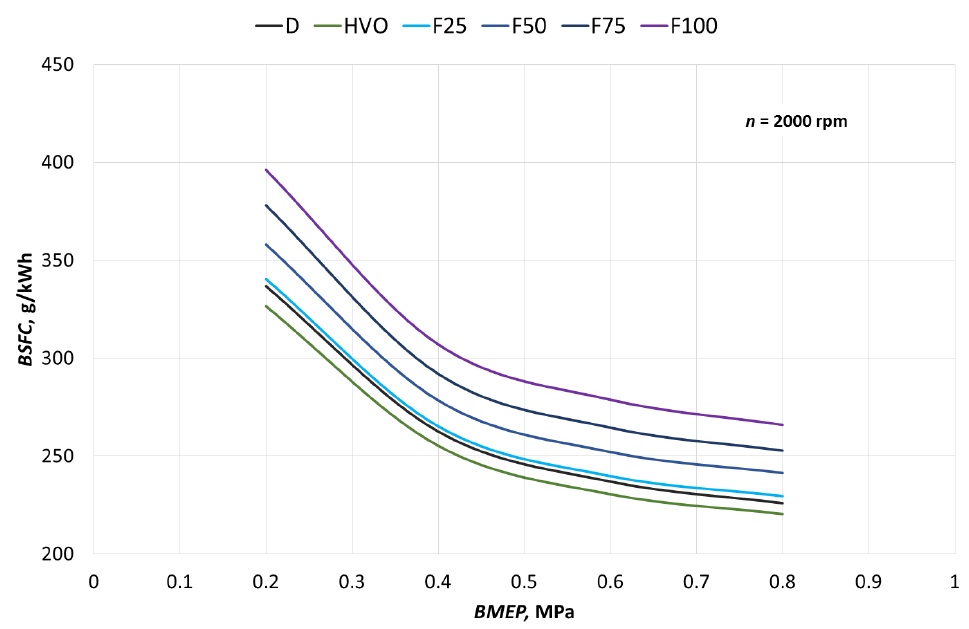
Figure 12. Dependence of BSFC, g/kWh on the load using different fuels.